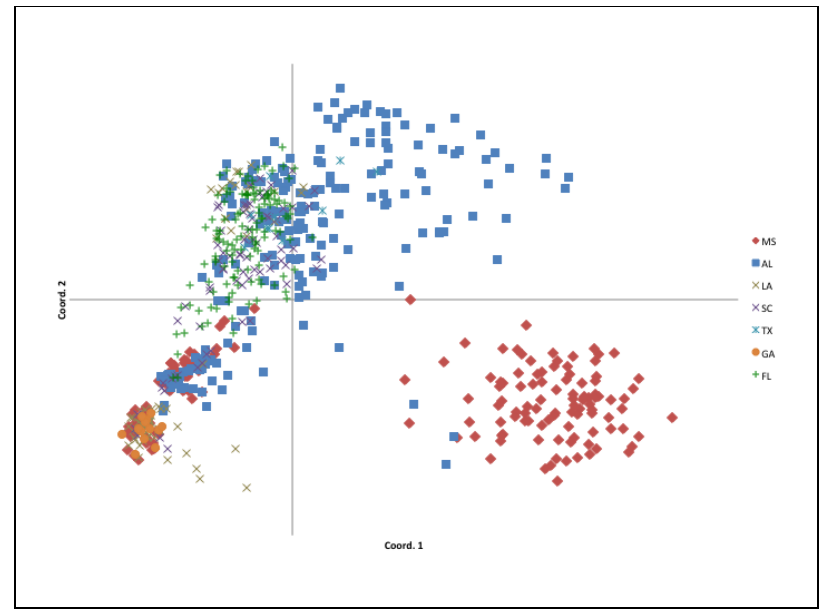
Figure 4. Principle coordinates analysis (PCoA) of individual genetic covariance with data standardization (N = 676, 61% of variation accounted for by the first two axes). All seven US states are represented in this ordination.